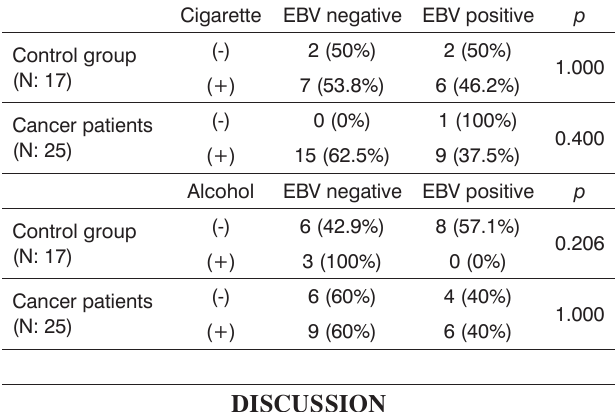
Table 2. Tobacco and alcohol consumption characteristics and EBV positivity rates of the